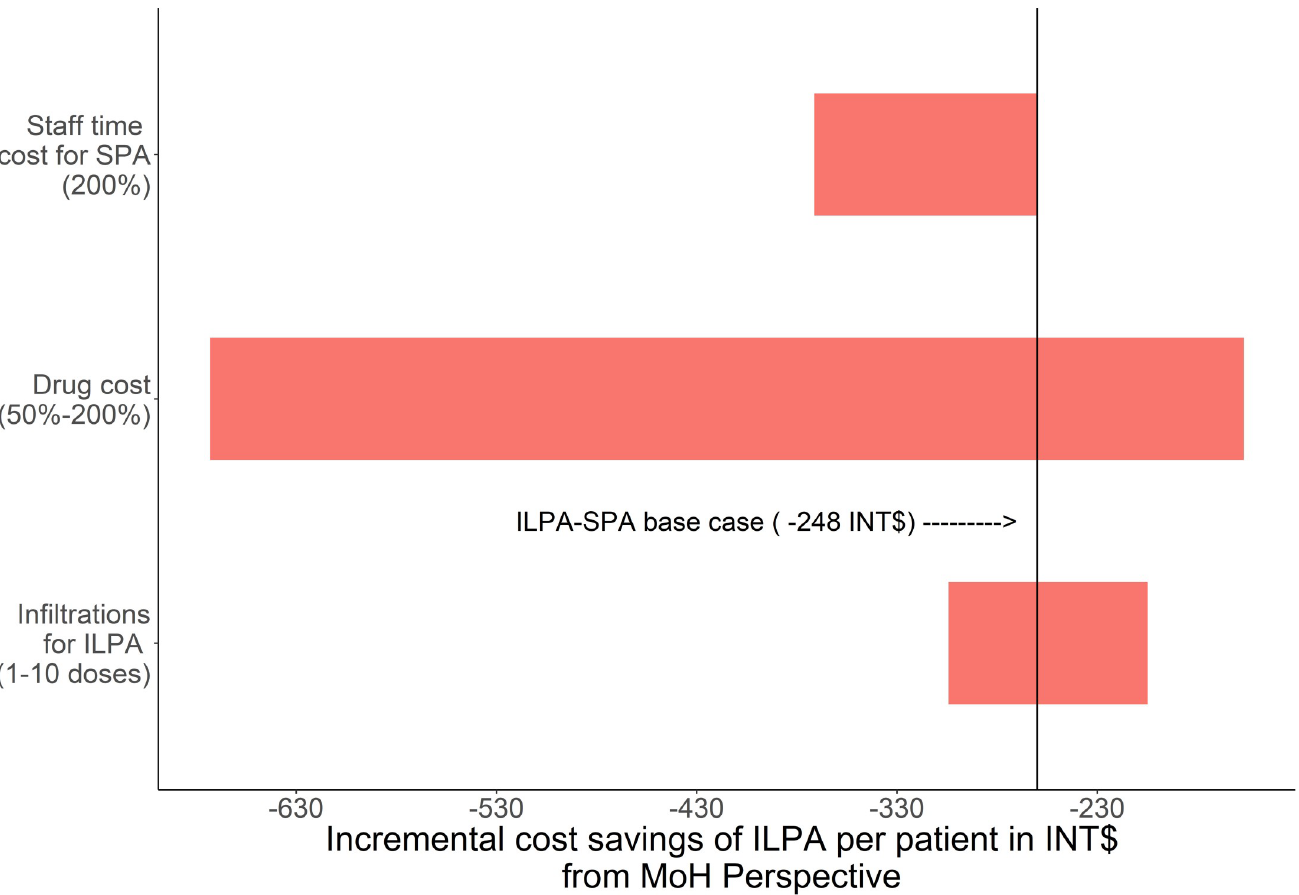
Fig 1. Tornado diagram of one-way sensitivity analyses of basic assumption effects on the incremental cost of ILPA expressed in INT$ from the MoH perspective.